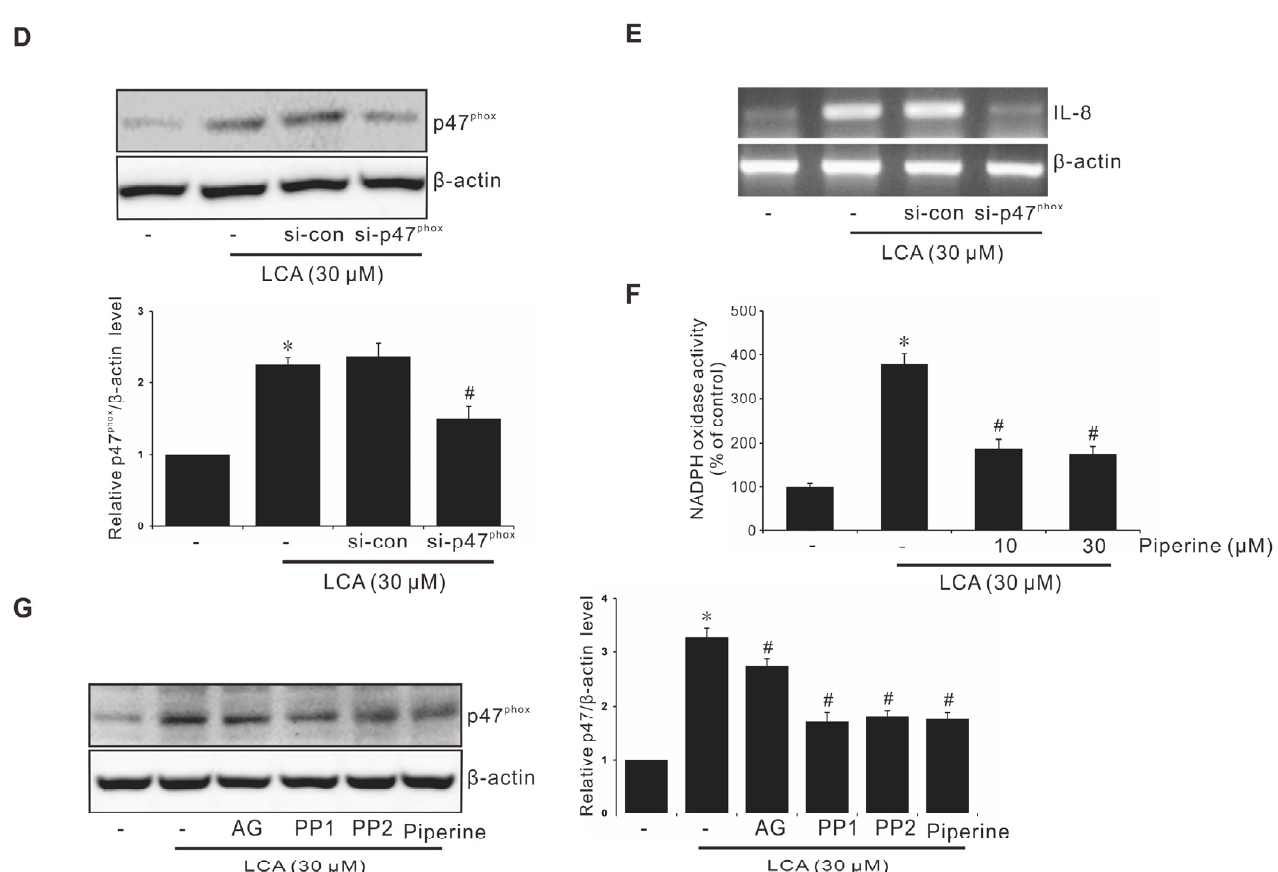
Figure 4. Inhibitory Role of Piperine in Activation of NADPH Oxidase-Derived Reactive Oxygen Species (ROS) during LCA-Induced IL-8 Expression in CRC Cells. ( A ) HCT-116 cells pretreated with N -acetyl- L -cysteine (NAC), diphenyleneiodonium chloride (DPI), or piperine for 1 h were incubated with 30 µ M LCA for 10 min. Cells were then treated with 5 µ g/mL of 5- and 6-carboxyl 2 (cid:48) ,7 (cid:48) -dichlorodihydro-fluorescein diacetate (DCFDA) in the dark for 10 min. DCF fluorescence was imaged using a confocal laser scanning fluorescence microscope, and the statistically significant values of ROS production are presented. Scale bar: 100 µ m. ( B ) Cells pretreated with NAC or DPI for 1 h were incubated with 30 µ M LCA for 4 h, followed by mRNA extraction and RT-PCR to determine IL-8 expression. ( C ) HCT-116 cells were transiently transfected with 500 ng pGL2-IL-8 promoter–reporter construct. These transfected cells were pretreated with NAC or DPI for 1 h and incubated with 30 µ M LCA for 4 h, and the luciferase activity was measured using a luminometer. Data represent the mean ± SEM from three experimental trials. * p < 0.05 versus control; # p < 0.05 versus LCA. ( D ) HCT-116 cells transfected with si-Con or si-p47 phox were incubated with 30 µ M LCA for 30 min; cell lysates were analyzed for p47 phox level using western blotting. ( E ) HCT-116 cells was transfected with si-Con or si-p47 phox were incubated with 30 µ M LCA for 4 h, and IL-8 mRNA level was measured using RT-PCR. ( F ) The NADPH oxidase activity measured by piperine pretreatment and LCA treatment. Data represent the mean ± SEM from three experimental trials. * p < 0.05 versus control; # p < 0.05 versus LCA. ( G ) HCT-116 cells pretreated with AG, PP1, PP2, or piperine for 1 h were incubated with 30 µ M LCA for 4 h, and cell lysates were analyzed for p47 phox level using western blot